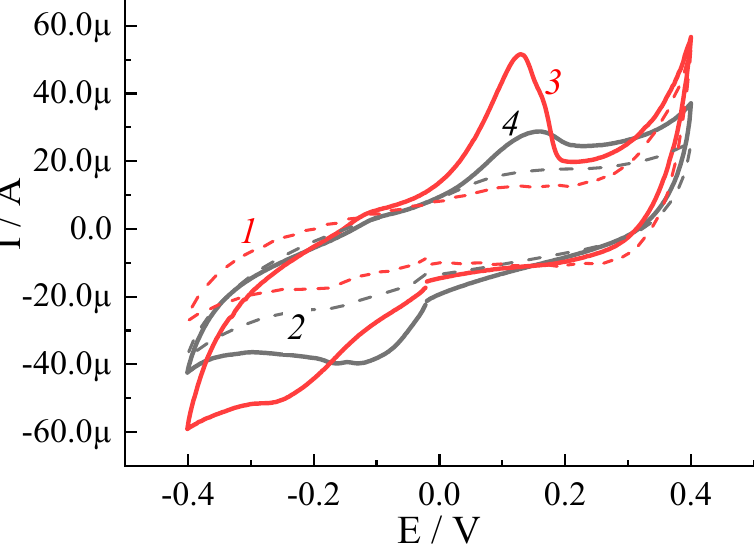
Figure 9. Cyclic voltammetry (CV) curves obtained from glassy carbon electrode (GCE) modified by (1, 3) pure CuI and (2, 4) CuI-PPy in 0.5 M H 2 SO 4 under inert (1, 2) and oxygen (3, 4) atmosphere. pH 1, scan rate 20 mV/s.